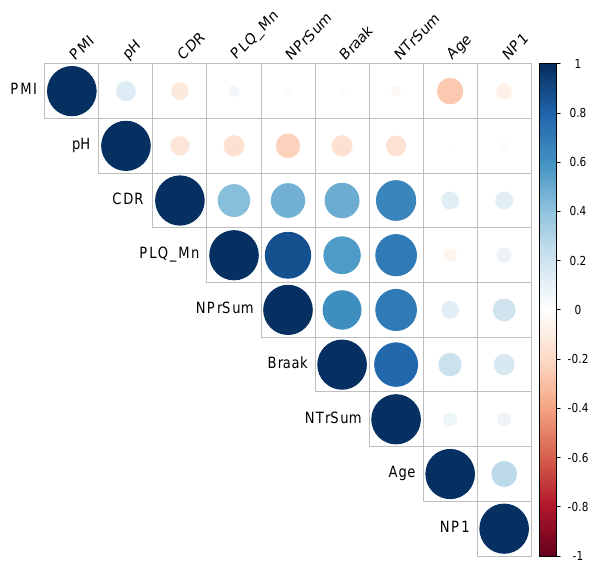
Figure 2. Pearson’s correlation matrix of all nine covariates (post-mortem index, pH, CDR, PLQ_Mn, NPr_Sum, Braak, NTr_Sum, Age, NP1) for all individuals in the MSBB Tissue Array Panel study.